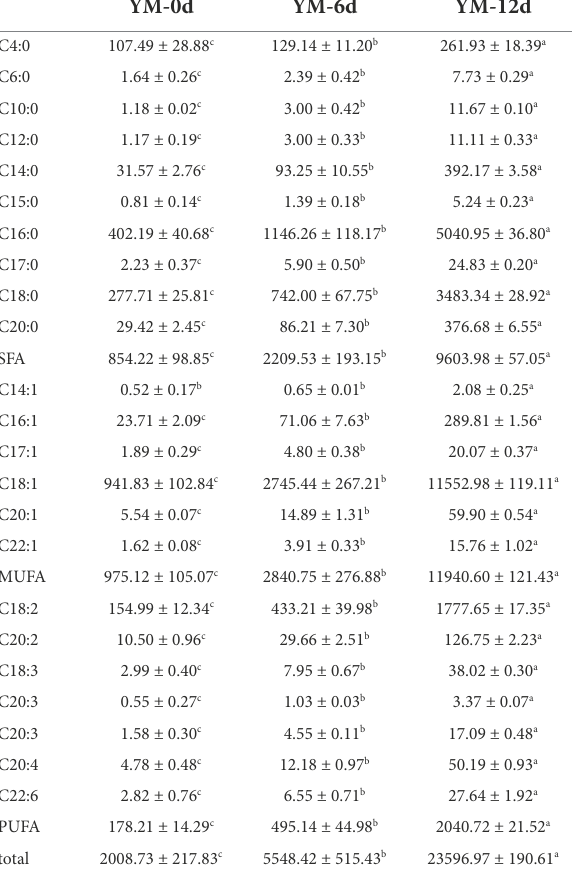
TABLE 3 Changes of free fatty acid components during maturation of fermented sausages (mg/kg).